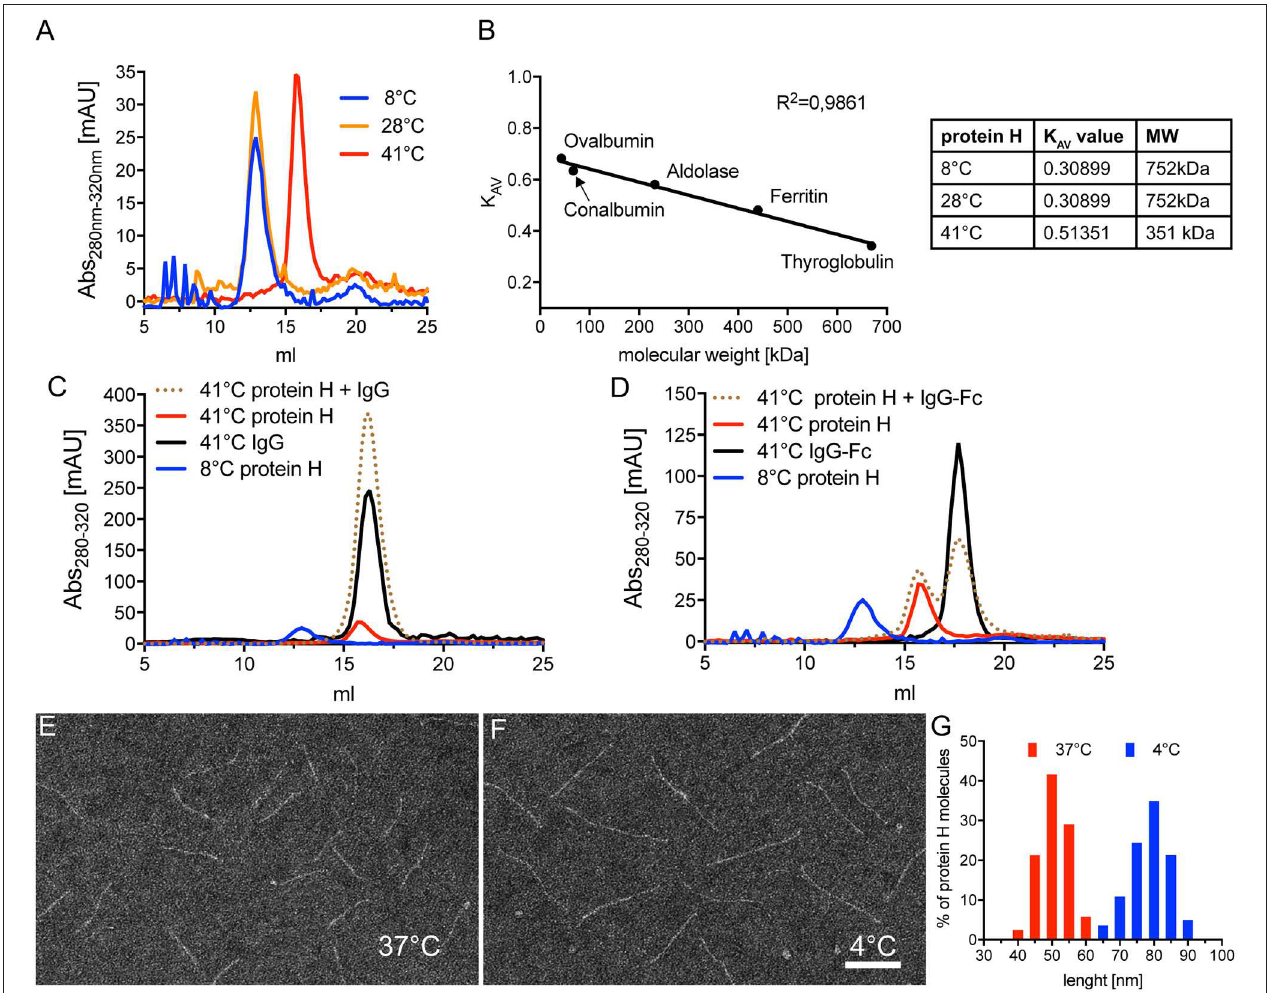
FIGURE 5 | Protein H dimerization is temperature dependent and crucial for IgG binding. (A) Size exclusion chromatography (SEC) analysis of 5 nmol Protein H at different temperatures using a Superose 6 10/30 column. (B) Calibration of SEC on a Superose6 10/30 column using high molecular weight marker proteins to allow estimation of protein sizes. For size estimation of mono- and dimers of Protein H, KAV values were calculated using the formula KAV (Ve-Vo)/(Vt-Vo) with Ve elution = = volume in ml; Vo void volume (estimated with blue dextran 2,000 8.67ml) and Vt total column volume (estimated by salt peak 22.36ml). (C,D) SEC analysis = = = = of 5nM Protein H with equimolar amounts of IgG’s at different temperatures using a Superose6 10/30 column. Protein H does not bind denosumab (C) or pooled IgG-Fc (D) at 41 ◦ C. As a reference for Protein H dimers, 4 ◦ C run of Protein H was inserted into both diagrams. Electron microscopy images of negative stained Protein H at 37 ◦ C (E) and 4 ◦ C (F) . (G) Size distribution of Protein H molecules at different temperatures. Representative experiments of at least 3 independent repetitions are shown. In (E–G) more than 500 molecules for each temperature from different areas on several microscopy grids were analyzed. Bar in (F) indicates